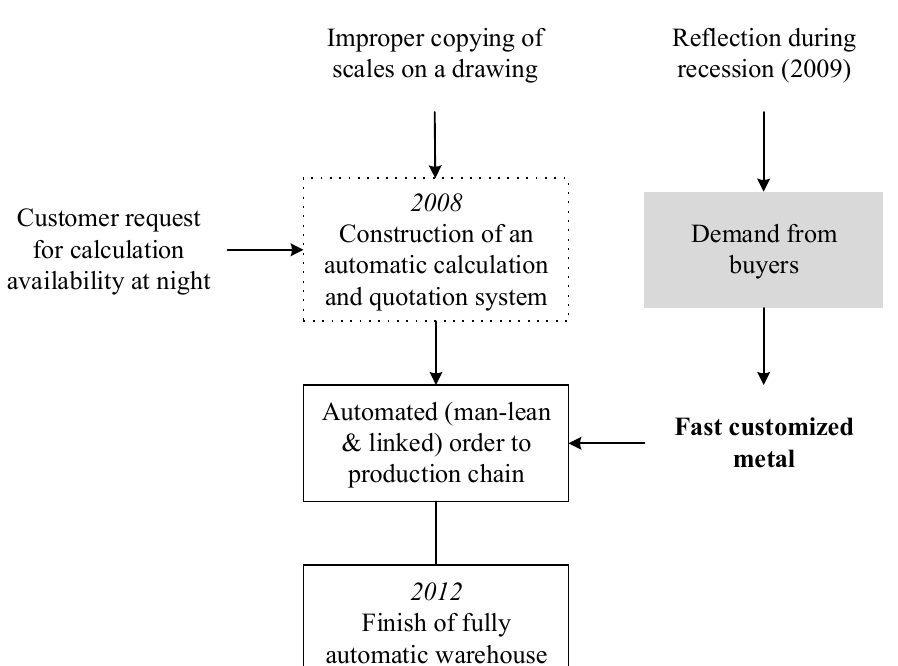
Adm. Sci. 2020 , 10 , 30